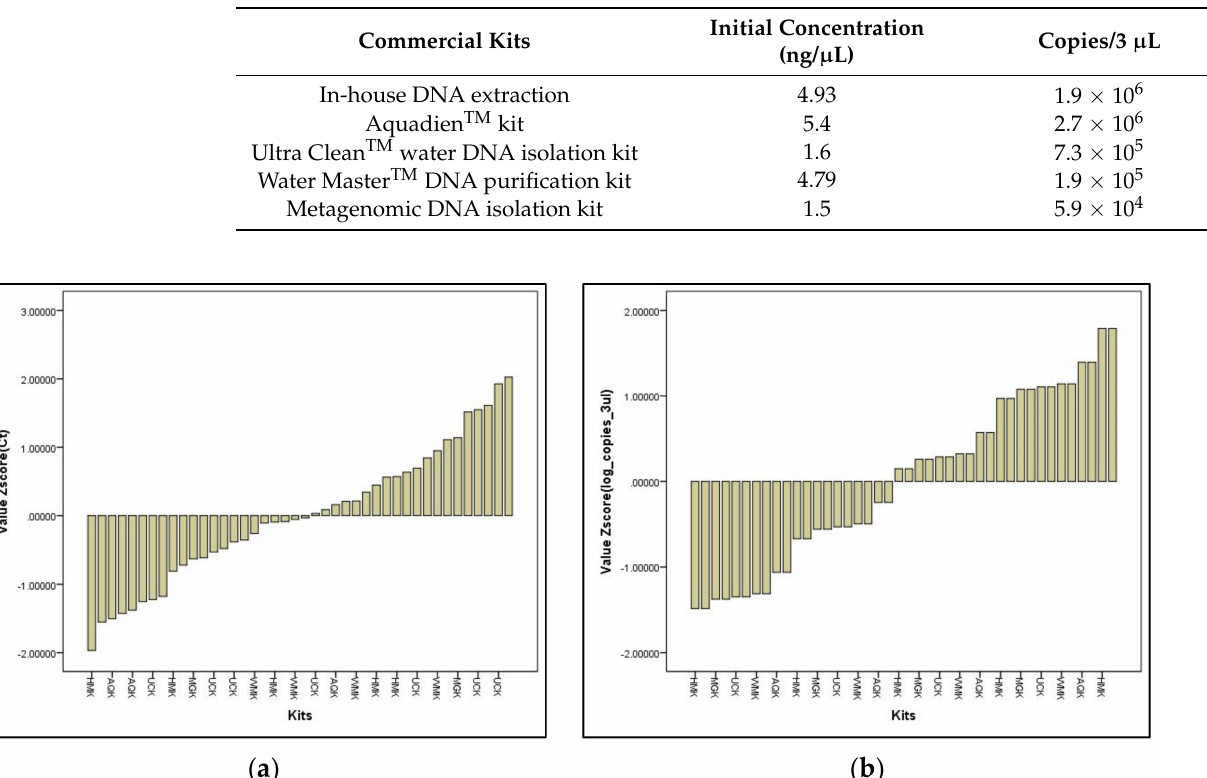
Table 2. Starting template DNA concentration added for the q-PCR standard curves.